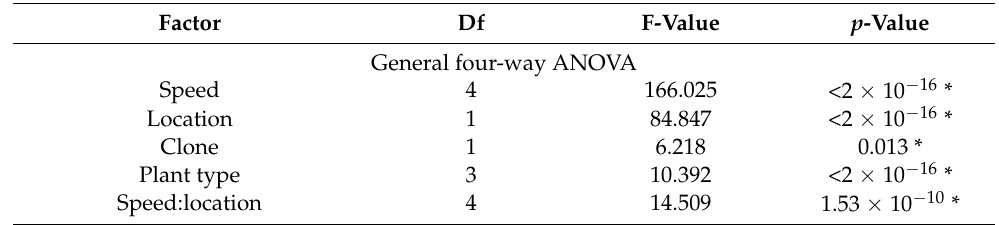
Table 6. Zasso experiment. Results of the four-way ANOVA test performed in order to evaluate the main and interaction effects of the factors speed, location, clone, and plant type on C. esculentus shoot vitality. As the interaction term speed:location was significant, a separate three-way ANOVA test was performed for each location to assess the main and interaction effects of the factors speed, clone and plant type on C. esculentus shoot